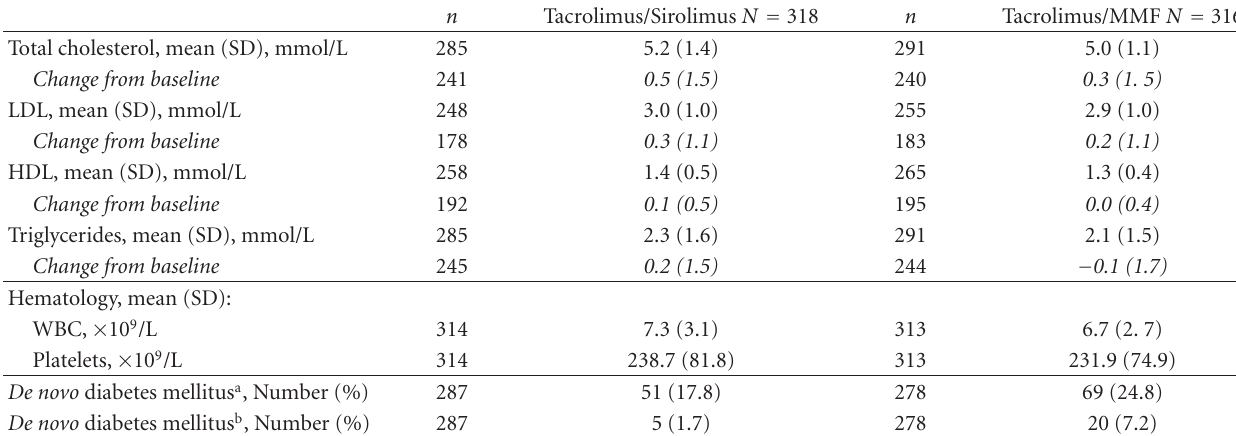
Table 5: Clinical laboratory results, concomitant medications, and safety results.